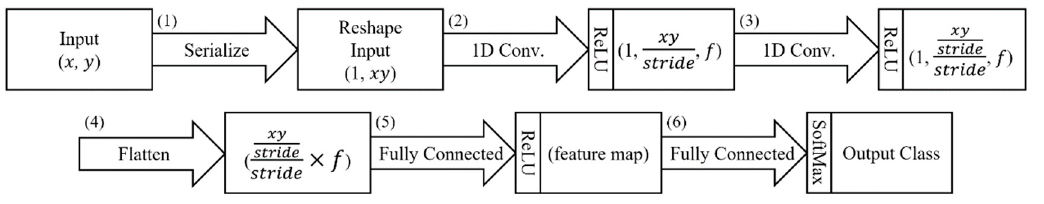
Figure 8. The basic form of the proposed neural network model.